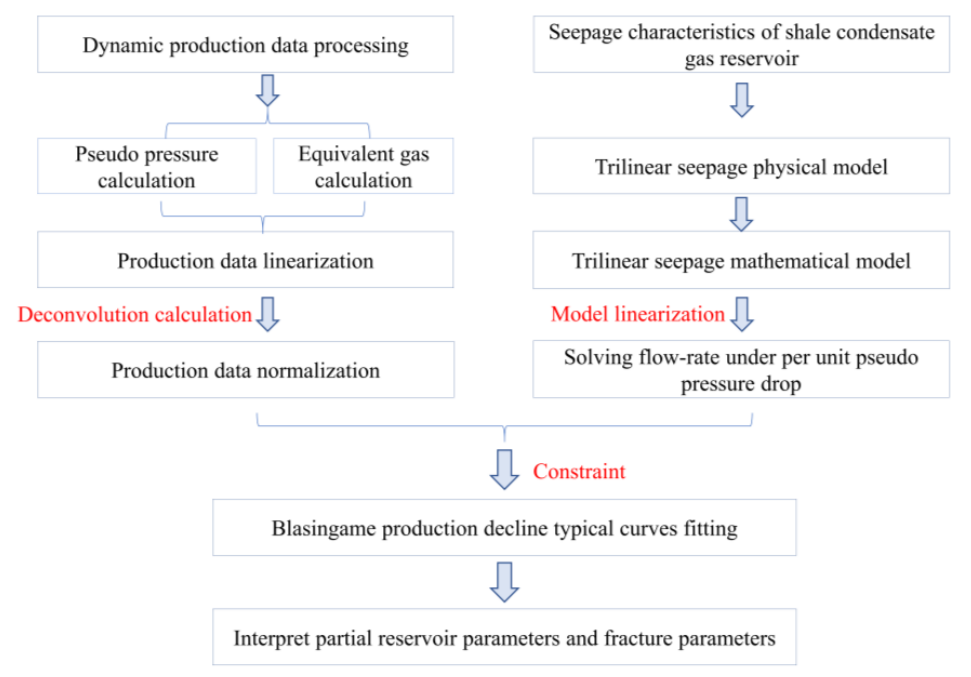
Figure 2. The flow chart of the production dynamic data analysis method for shale condensate gas reservoirs based on flow rate deconvolution.